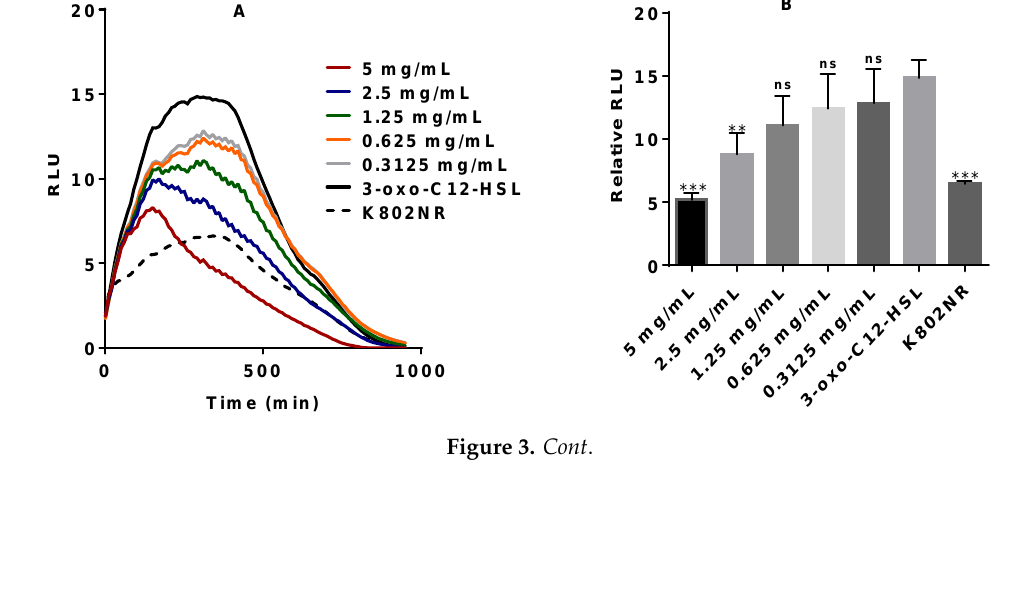
Figure 2. Experimental and theoretical mass spectrum of CSHS using ion trap MS in positive ion mode. ( A ) Stevioside; ( B ) Reb A; ( C ) steviol. On the right are the structures of the glycosides, along with their molecular formulas.